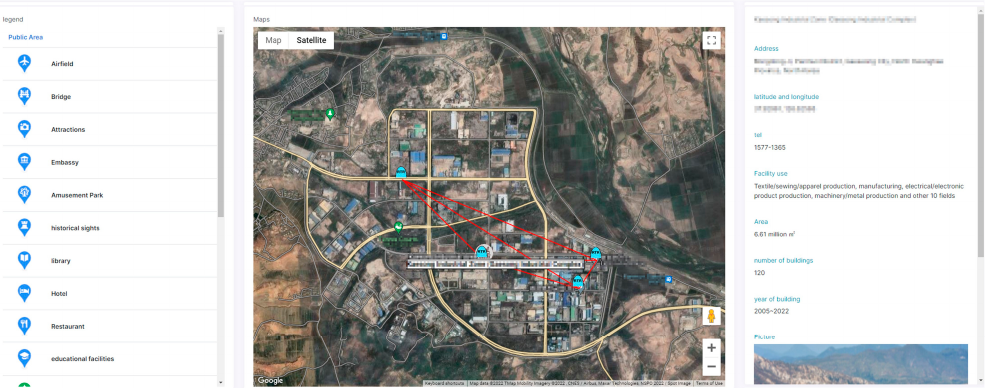
Figure 9. Visualization ③ : Visualization of Physical Network Device Location and Information within the Facility.